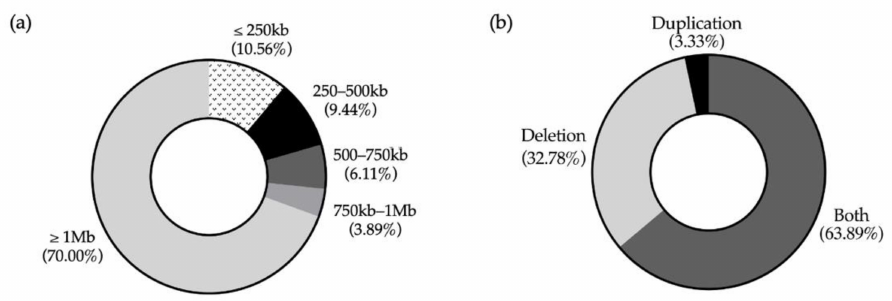
Figure 5. Characteristics of SROs. ( a ) Breakdown of SROs by size. ( b ) Breakdown of SROs by CNV